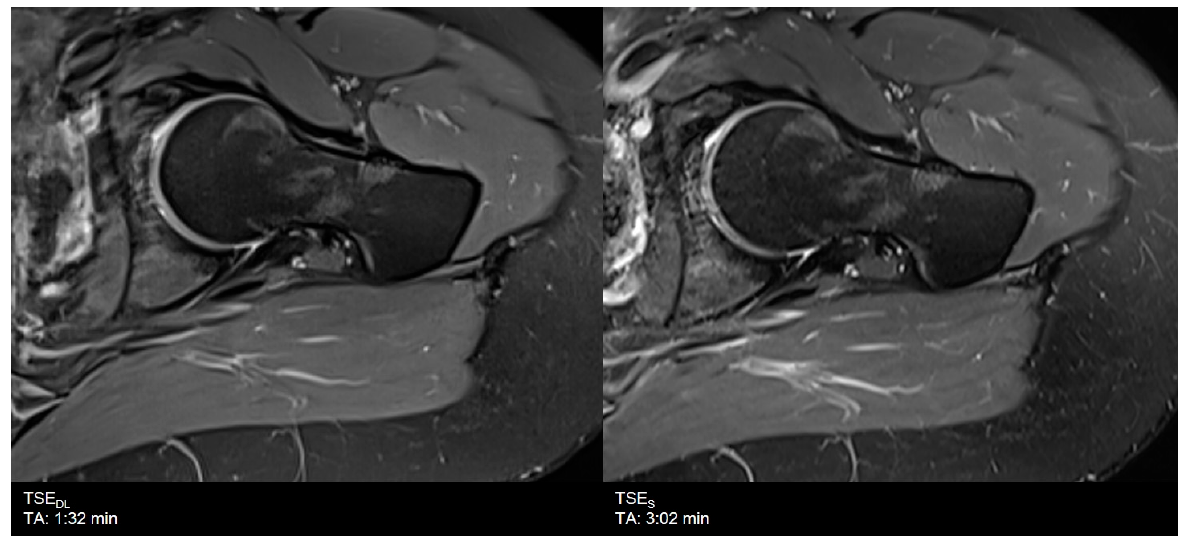
Figure 6. Example of a Deep Learning ( left ) and standard ( right ) PD-weighted turbo spin echo image of the hip in axial orientation. Note that although the assessment of the bone was rated to be lower, the assessment of anatomical structures and articular cartilage, as well as the delineation of ligaments and tendons, are comparable between TSE DL and TSE S.